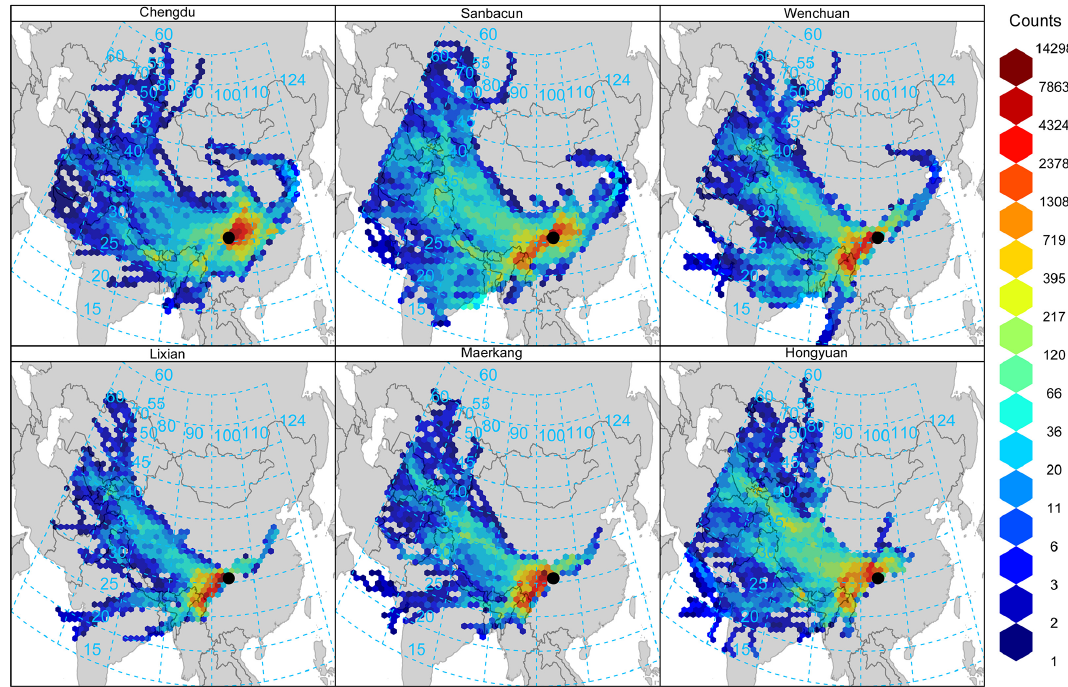
Figure 11. Gridded back-trajectory frequencies with hexagonal binning in winter at the six sites from the western Sichuan Basin to the Tibetan Plateau. The map is a reproduction from Google Maps with added the trajectory frequencies. Copyright © Google